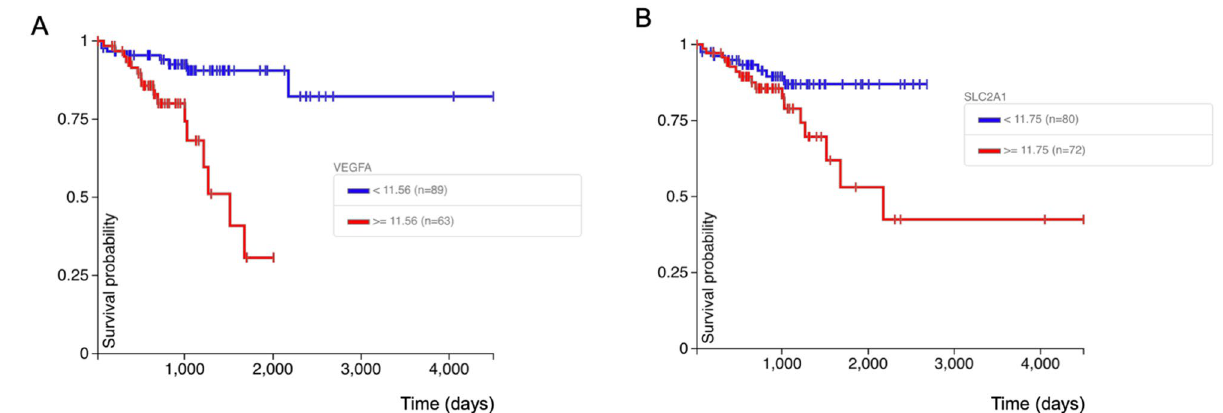
Figure 8. Correlation between the overexpression of HIF1α target genes VEGFA and SLC2A1 and poor disease- free interval. The analysis was performed with the UCSC Xena tool (https:// xena. ucsc. edu/) on TCGA colon and rectal cancer samples. ( A ) Correlation between VEGFA expression and disease-free interval. p value = 0.0001. ( B ) Correlation between SLC2A1 expression and disease-free interval. p value =